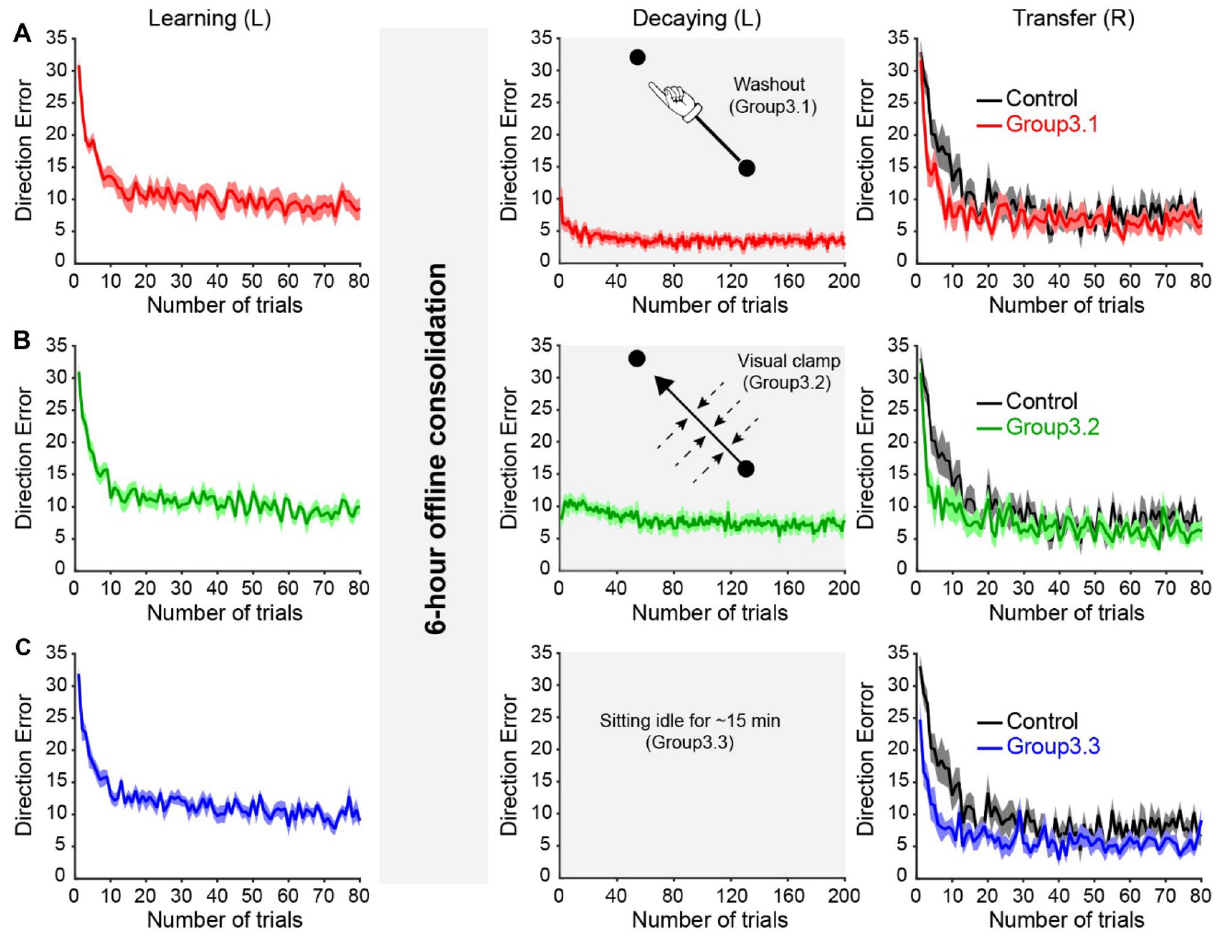
Figure 5. Performance of Experiment 3. ( A ) The movement errors of Group3.1 in the learning, decaying, and transfer sessions were plotted in red lines and shaded areas (mean ± standard error). The decaying session was 6 h after the learning, and the setup was identical to Group 1.1. The performance of the control group was plotted as the black line on the right panel. The movement errors of Group3.2 and 3.3 were plotted in ( B ) and ( C ), respectively. The setup of the decaying session for Group3.2 was identical to Group2.1, and the setup for Group3.3 was identical to that for